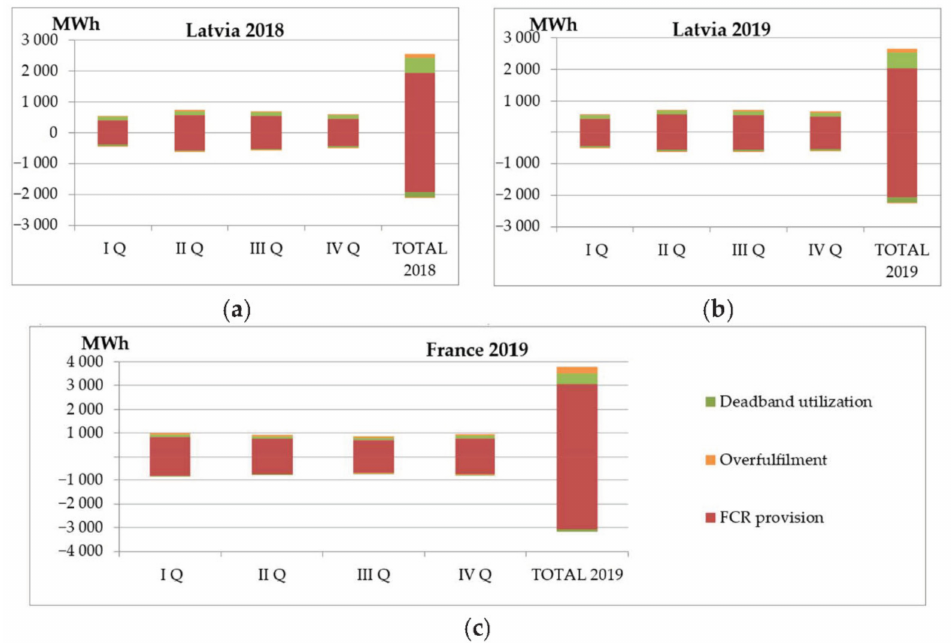
Figure 8. BESS performance for FCR provision and SOC management: ( a ) in Latvia 2018, ( b ) in Latvia in 2019, ( c ) in France in 2019.